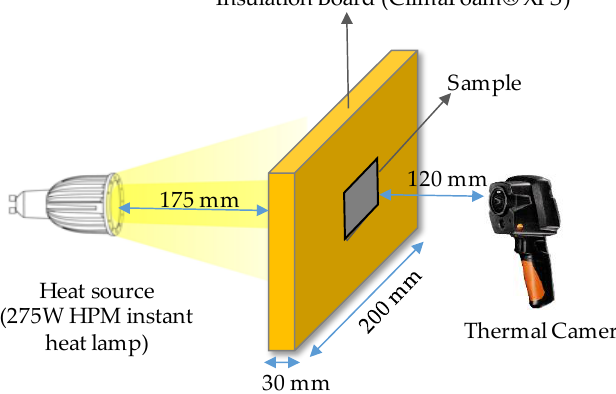
Figure 5. Infrared thermography test.